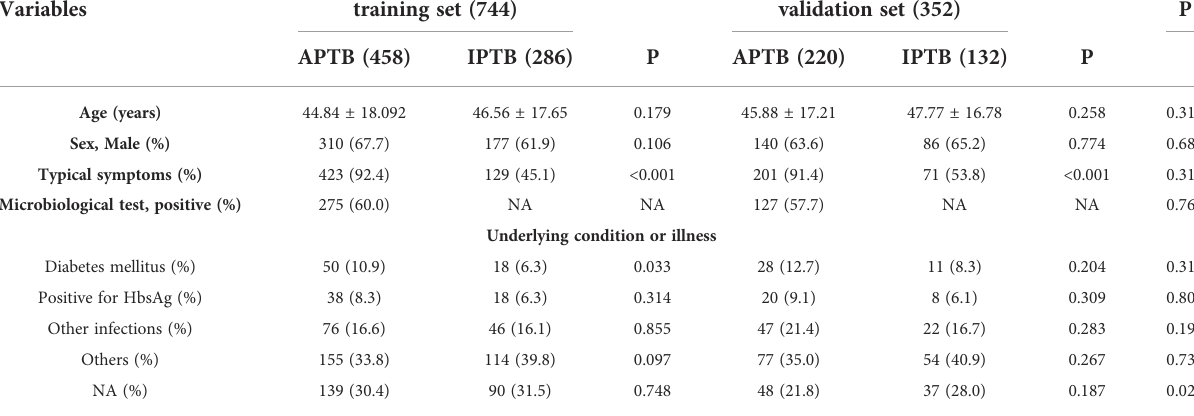
TABLE 1 Demographic, clinical, and laboratory characteristics of the training set and validation